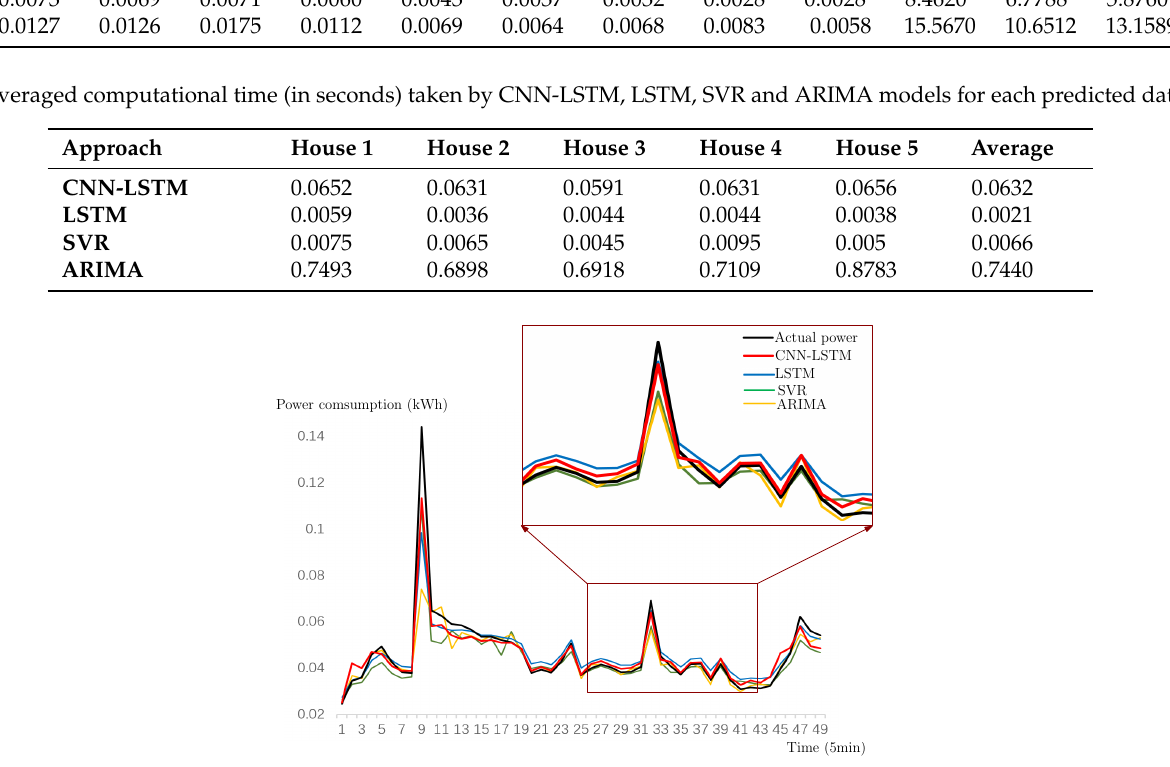
Figure 4. The prediction results for household 1 power consumption data using various methods. The dark red box shows a zoom-in region of the prediction